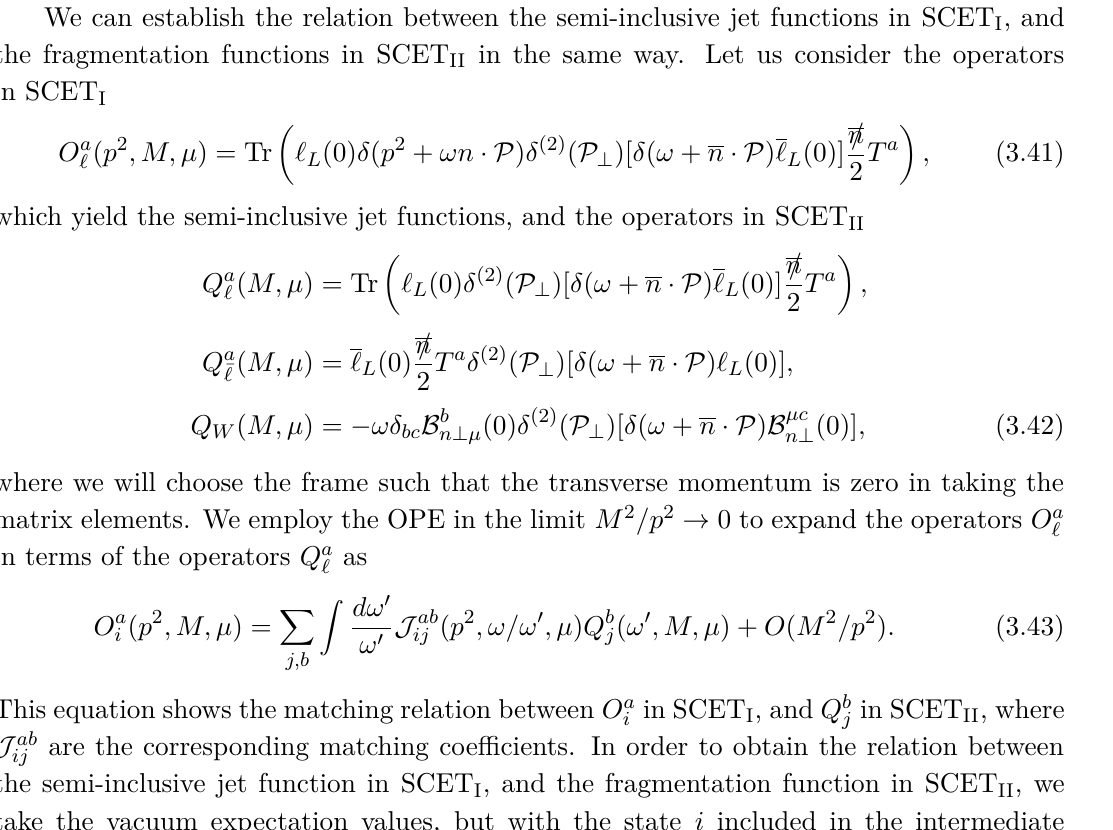
Figure 1 . In SCET II , the collinear and soft modes lie on the same mass shell p 2 The hard-collinear modes with p 2